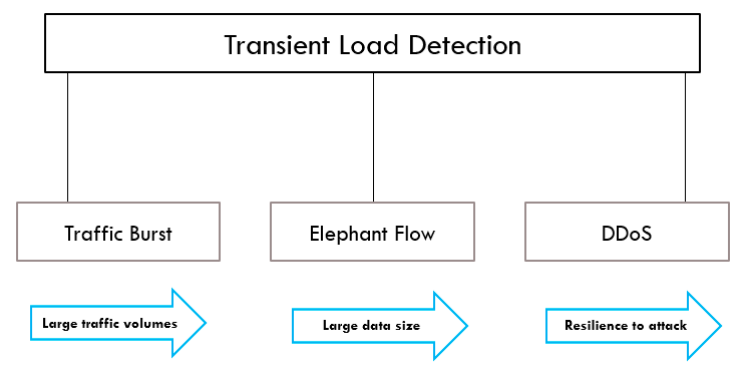
Figure 2. Transient load detection.